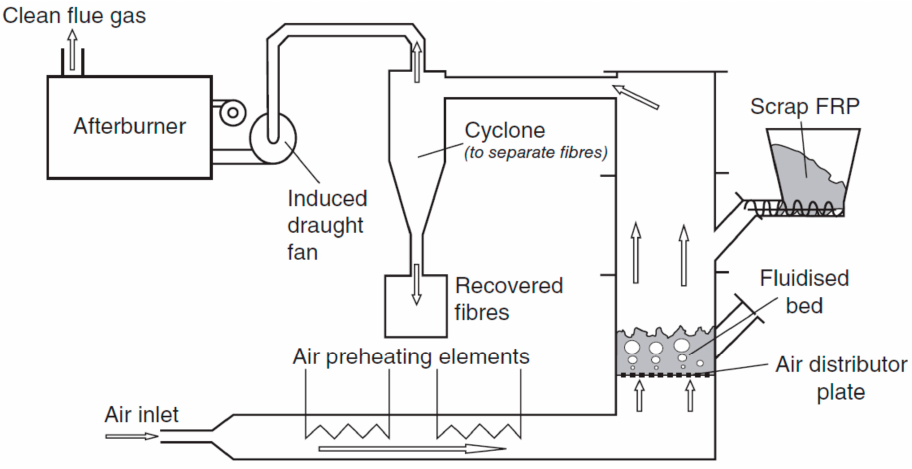
Figure 22. Schematics of fluidized bed recycling process [201].